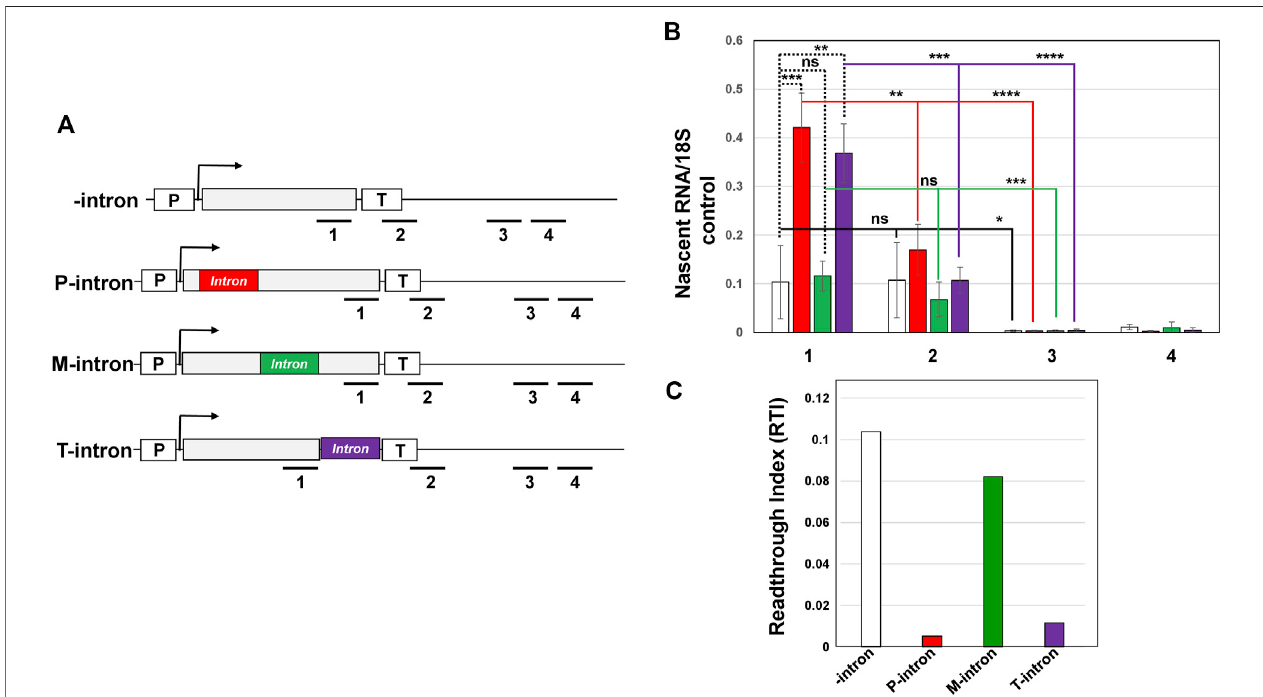
FIGURE 6 | Presence of an intron does not affect termination of transcription of IMD4 . (A) Schematic depiction of IMD4 with intron inserted near the promoter (P-intron), middle of the gene (M-intron) and near the terminator region (T-intron), showing the position of primers 1, 2, 3, and four used in strand-speci fi c TRO analysis. “ p ” and “ T ” standforthepromoterandterminatorrespectively. (B) Strand-speci fi cTROanalysisshowingthatthepolymerasedidnotreadthroughintheregions2,3,and four downstream of the terminator signal of IMD4 in the construct P-intron (red bar), M-intron (green bar) and T-intron (purple bar). The 18S signal was used as a normalization control in these experiments. Results presented here represent three biological replicates and six technical replicates. The values and error bars for each condition indicate themean ± standard deviation. Statistical signi fi cance ( p -values) wasdetermined using thetwo-tailed paired Student ’ s t -test. One asterisk (*) signi fi es a p value equal to or smaller than 0.05 ( p ≤ 0.05). Two asterisks (**) signify a p value equal to or smaller than 0.01 ( p ≤ 0.01). Three asterisks (***) indicate p value equal/ smallerthan0.001( p ≤ 0.001).Fourasterisks(****)indicate p valueequal/smallerthan0.0001( p ≤ 0.0001).Anynon-signi fi cantdifferenceisrepresentedbyns( p > 0.05). (C) ReadthroughIndex (RTI)wascalculatedbydividingtheTROsignalintensitybeyondthe3 ′ endofthegene(region4) withthesignalvaluebeforethe3 ′ end withinthe coding region (region